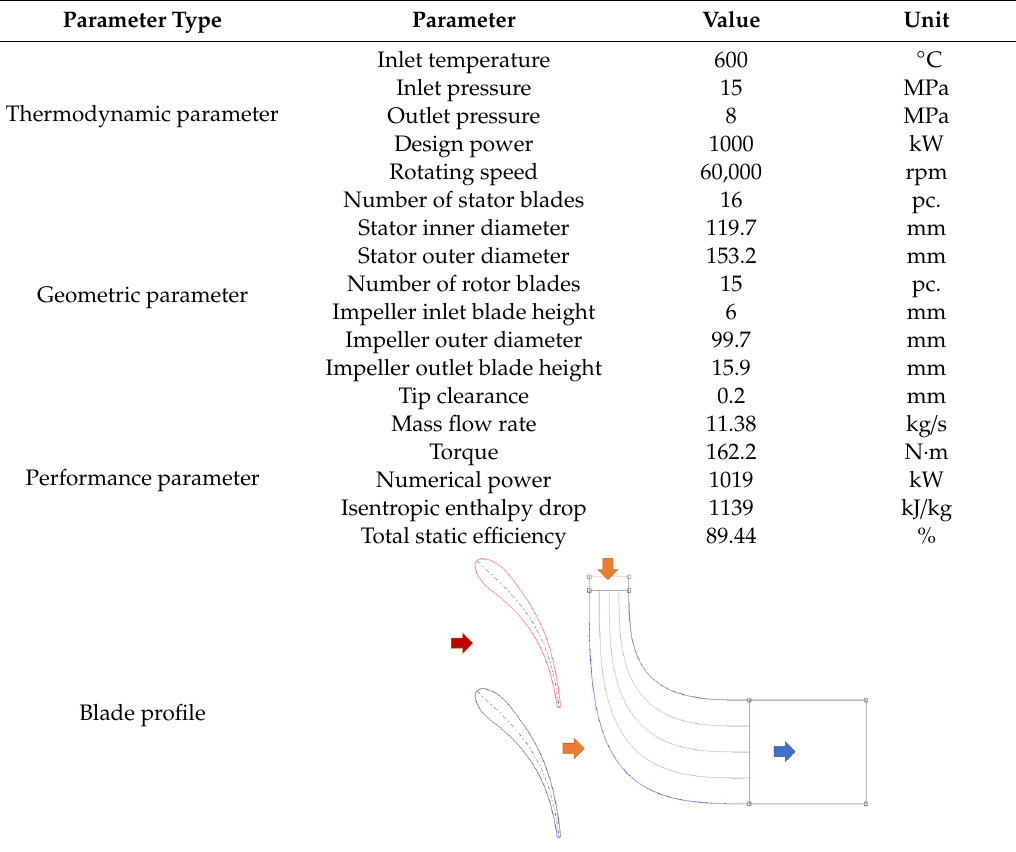
Table 2. Key design